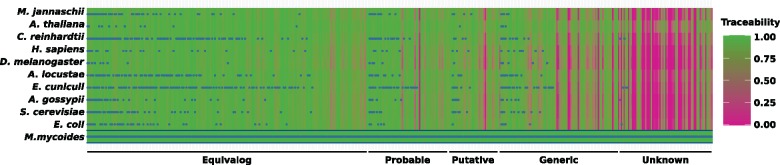
—Phylogenetic distribution and traceability profile for the Syn3.0 minimal gene set. The background color gives the information of the traceability index. The categorization according to the functional annotation status of the individual proteins was adapted from Hutchison et al. (2016).